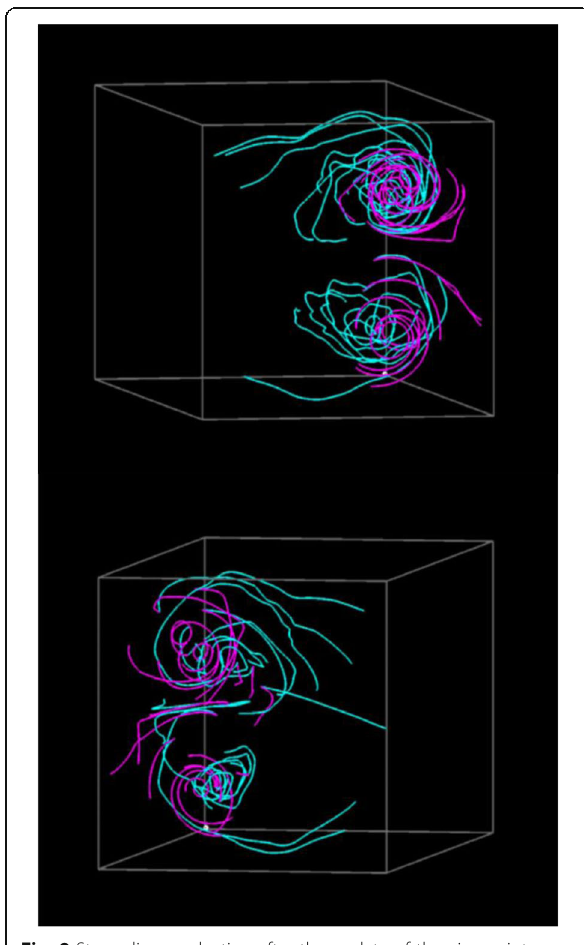
Fig. 9 Streamline reselection after the update of the viewpoint